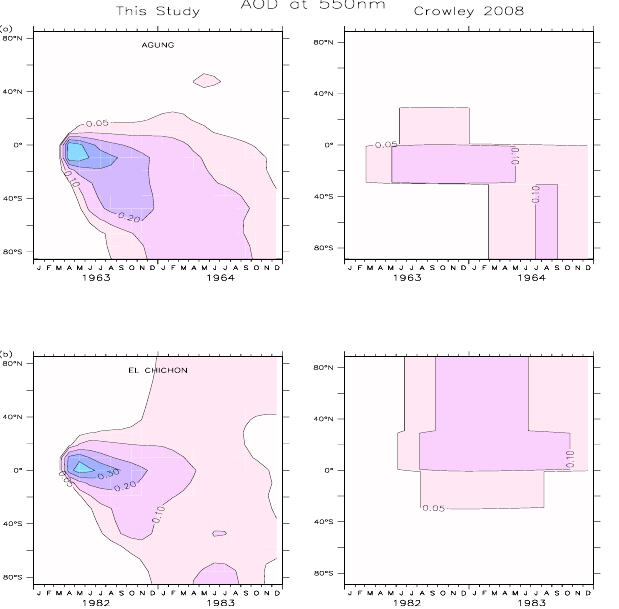
Fig. 9. Latitudinal distribution of the optical depth in VIS (550nm) for the Agung (1963) and El Chichón (1982) eruptions for this study (left column) and Crowley et al. (2008) (right column).